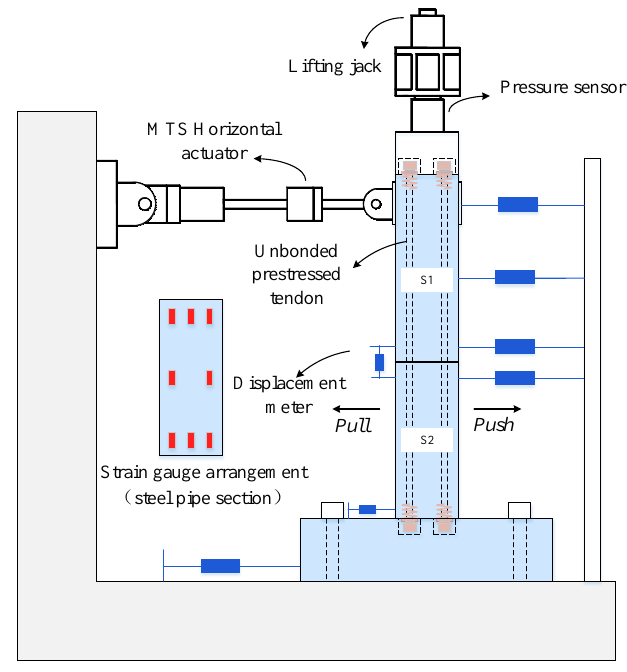
Figure 3. Layout of measuring points.